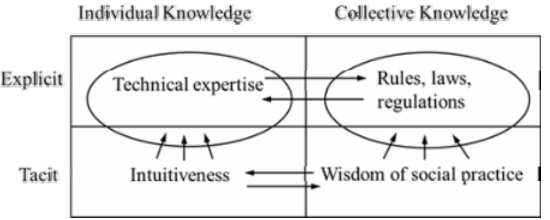
Figure 2. Model of Knowledge Conversion according to Baumard Notes of Figure 2: Firstly, knowledge is explicit and individual, techniques that allow us to counter nets and traps. Secondly, we achieve collective knowledge and profound knowl- edge of a terrain, environment, rules and laws. Thirdly, knowledge is tacit and collective, which is of the unspo- ken, of the invisible structure of a practice. Lastly, knowledge is tacit and individual. Tacit expertise is com- plemented by “hard” technical knowledge - a sort of inimitable technical skills. These four forms of knowledge are